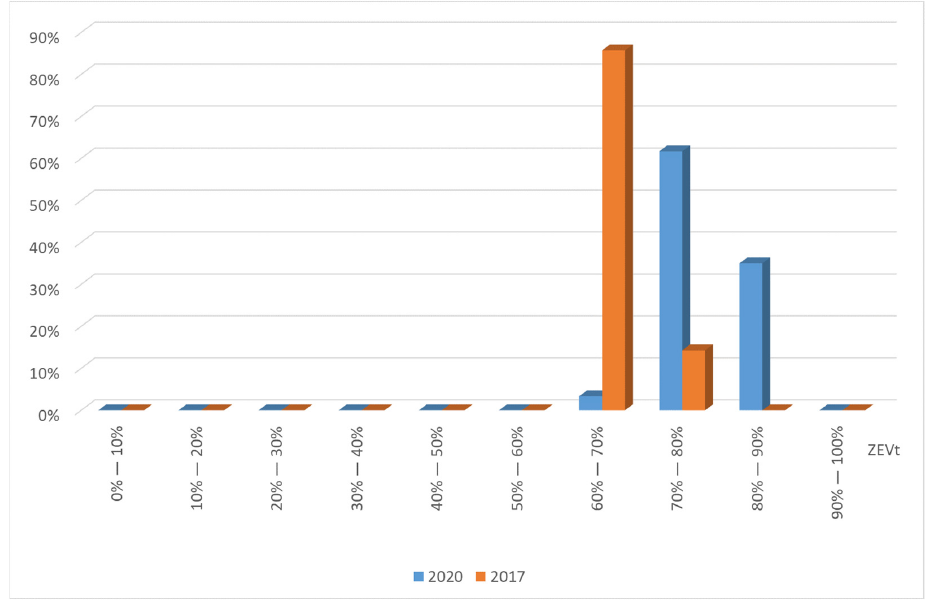
Figure 8. Frequency distribution of the ZEVt values.